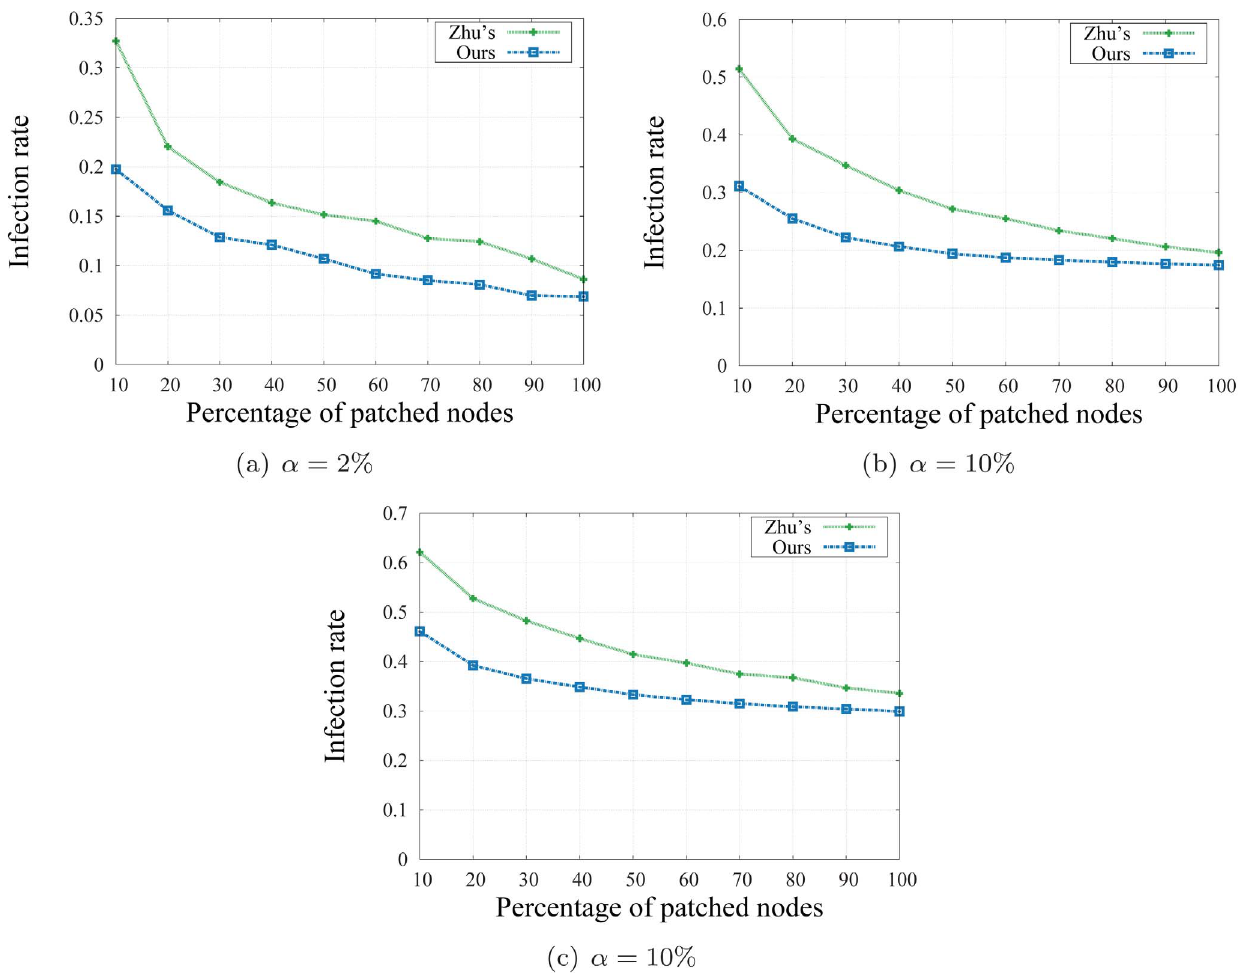
Figure 10. Infection rates on dynamic network with k =200 clusters.